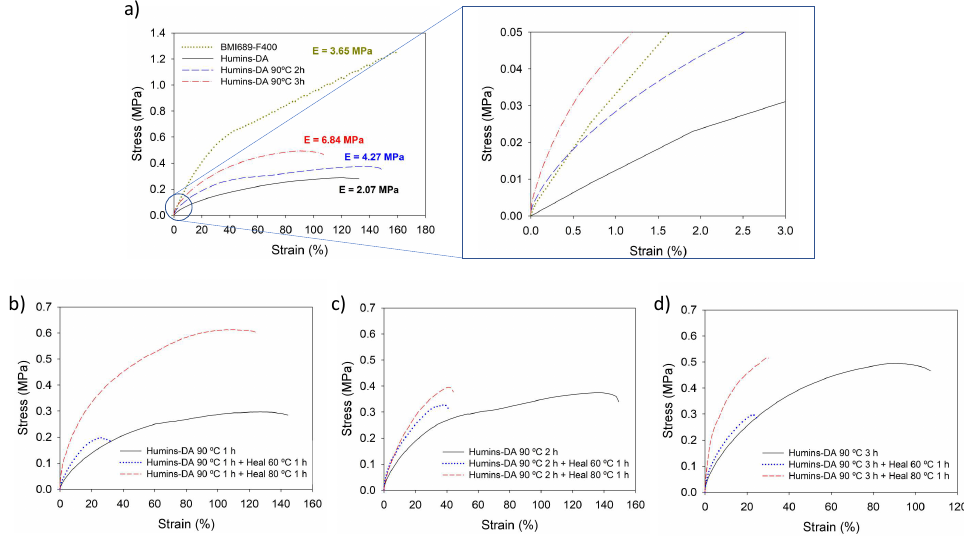
Figure 5. ( a ) Fracture tests for BMI689-F400 (yellow dotted line), Humins-DA as synthesized (black solid line), Humins-DA treated isothermally at 90 °C for two hours (blue dashed line) and three hours (red dash-dotted line). Fracture tests for Humins-DA (black line), Humins-DA healed at 60 °C for 1 h (blue dotted line), and Humins-DA healed at 80 °C for 1 h (red dashed line) when treated isothermally at 90 °C for ( b ) one hour, ( c ) two hours, and ( d ) three hours.